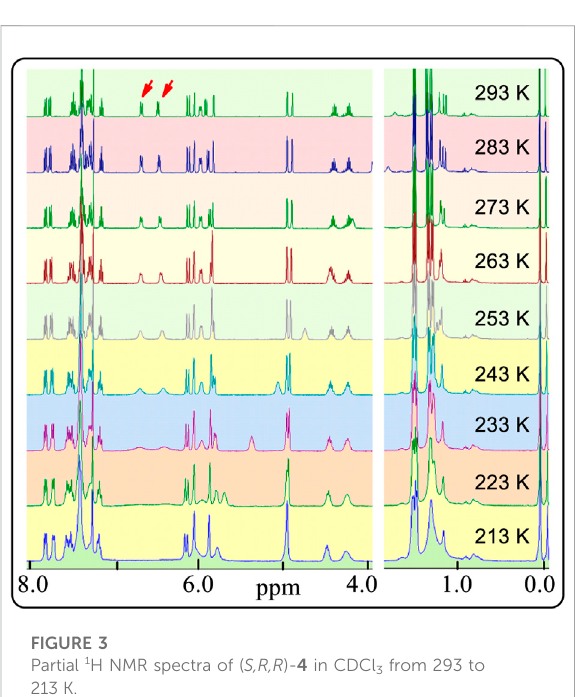
FIGURE 3 Partial 1 H NMR spectra of ( S,R,R )- 4 in CDCl 3 from 293 to 213